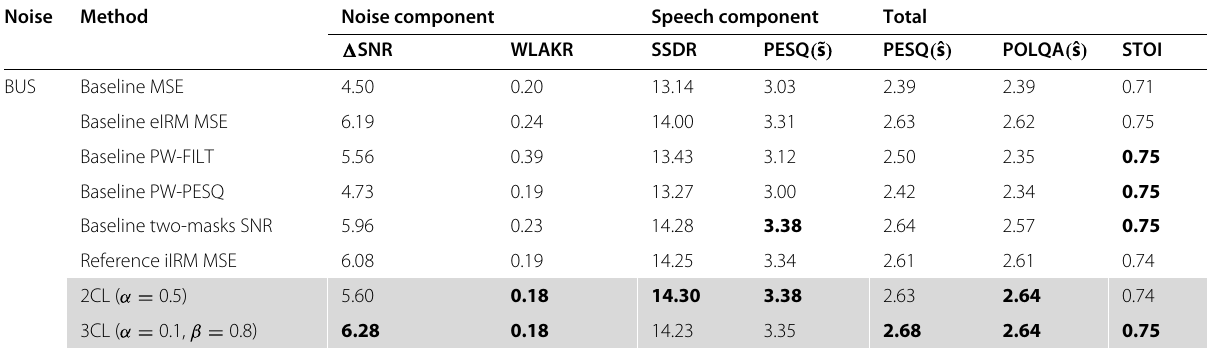
Table 8 Performance for unseen noise (BUS) on the test set ; All SNRs averaged. Best approaches from Tables 1 and 3 are gray-shaded; the best scheme is in boldface Noise Method Noise component